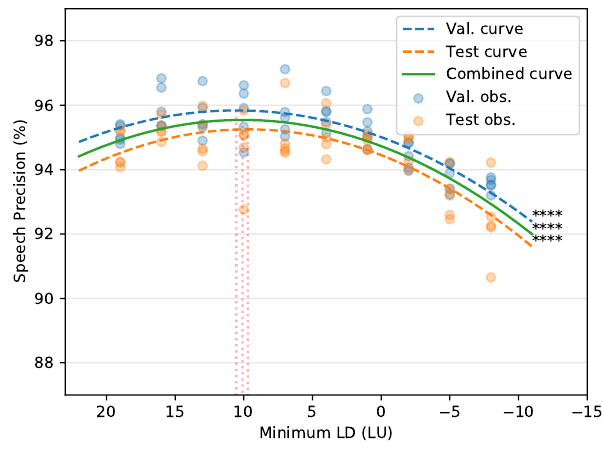
( a ) Precision of Speech. The vertical dotted lines in red indicate the maxima of the curves.